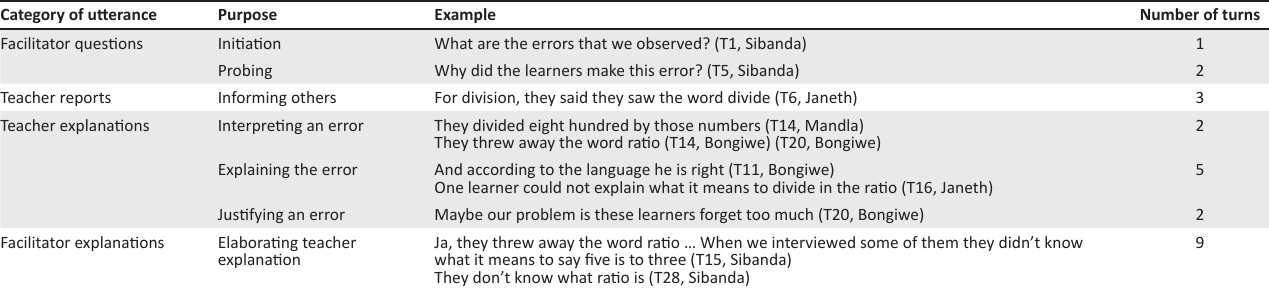
TABLE 2: Understanding a learner error. Category of utterance Purpose Example Number of turns Facilitator